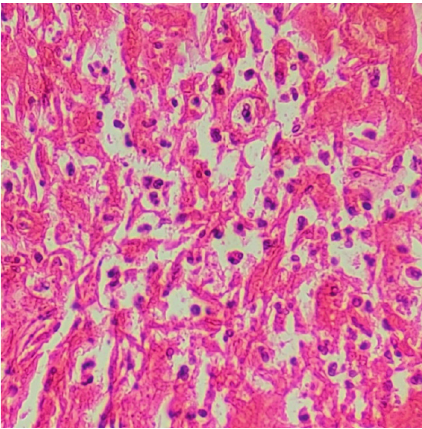
Figure 4: Eosinophil infiltration within the tissue (H&E stain, × 400).